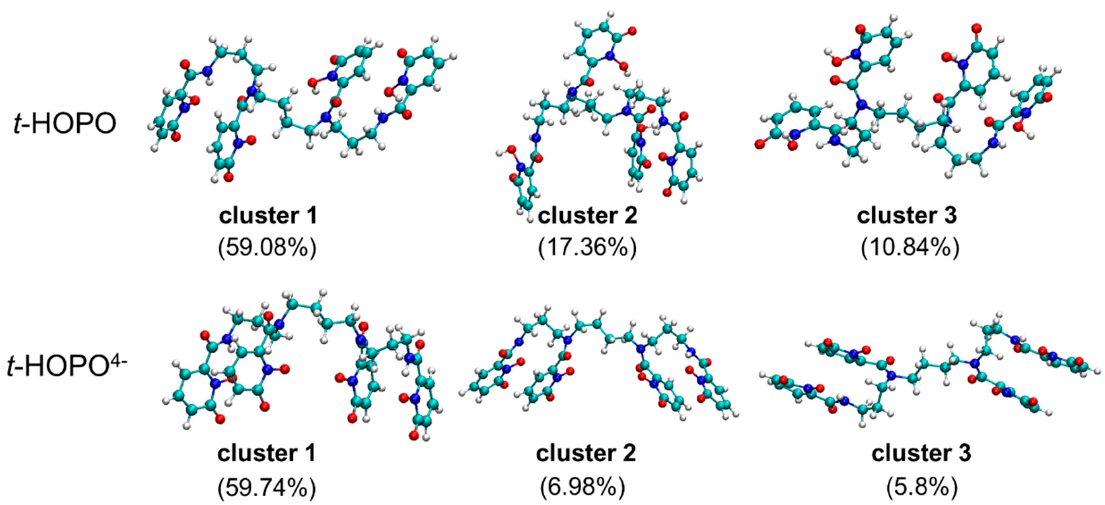
Figure 2. The central structures of top three clusters in the simulations of t -HOPO in its neutral (top) and deprotonated (bottom) states. The cutoff of t -HOPO is 0.35 nm, and the cutoff of t -HOPO 4 − is 0.18 nm. Color scheme: N atoms in blue, O atoms in red, C atoms in cyan and H atoms in white.